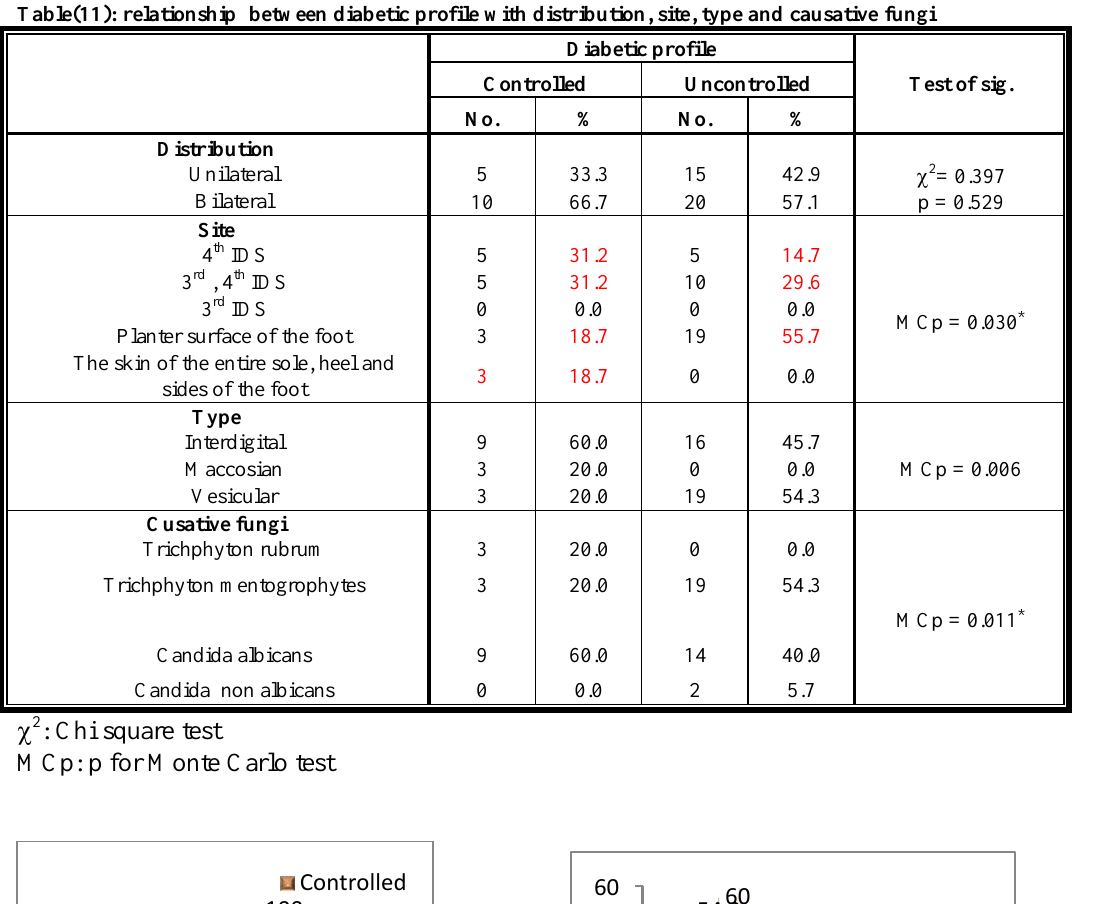
4. Relationship between diabetic profile with distribution, site, type & causative fungi: Table(11): relationship between diabetic profile with distribution, site, type and causative fungi